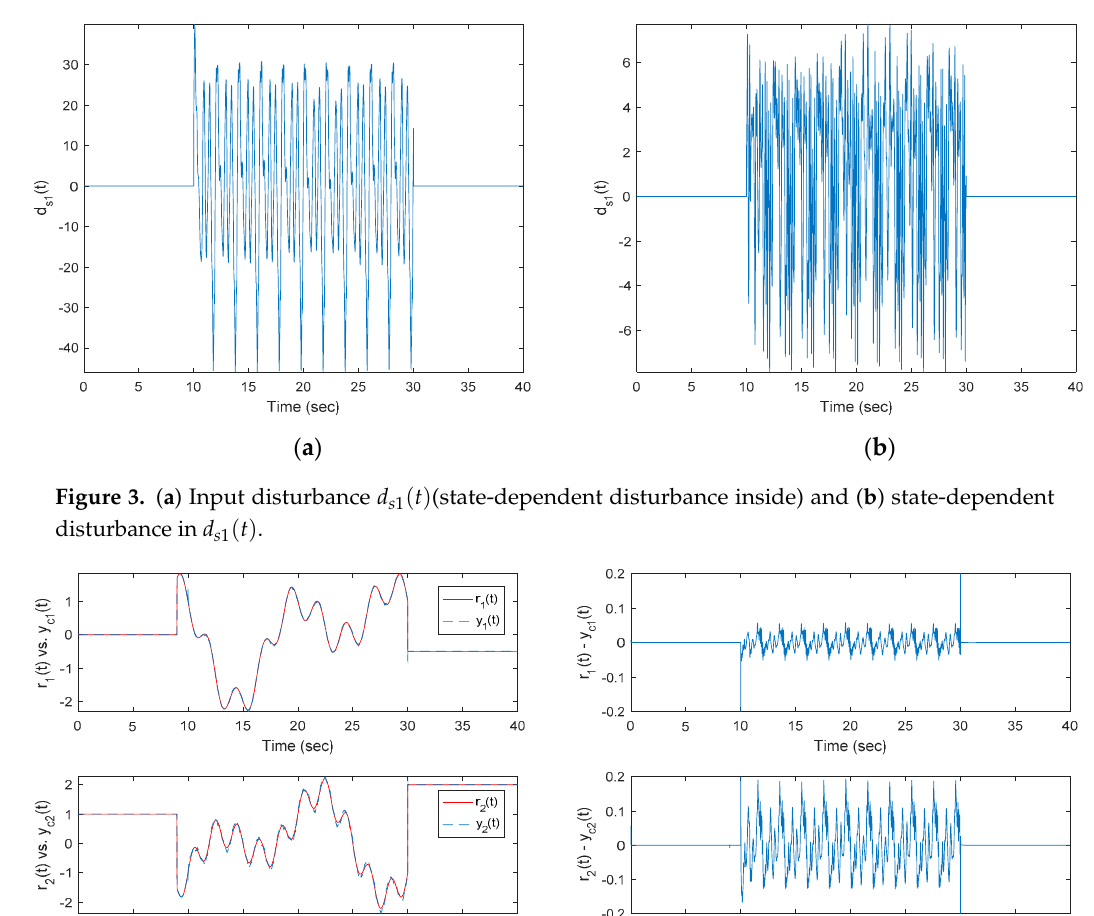
Figure 4. ( a ) Time responses of the closed-loop noisy square singular system for the optimal OKID-based LQAT without the EID estimator, ( b ) tracking errors of output e ( t ) = r ( t ) − y c ( t )